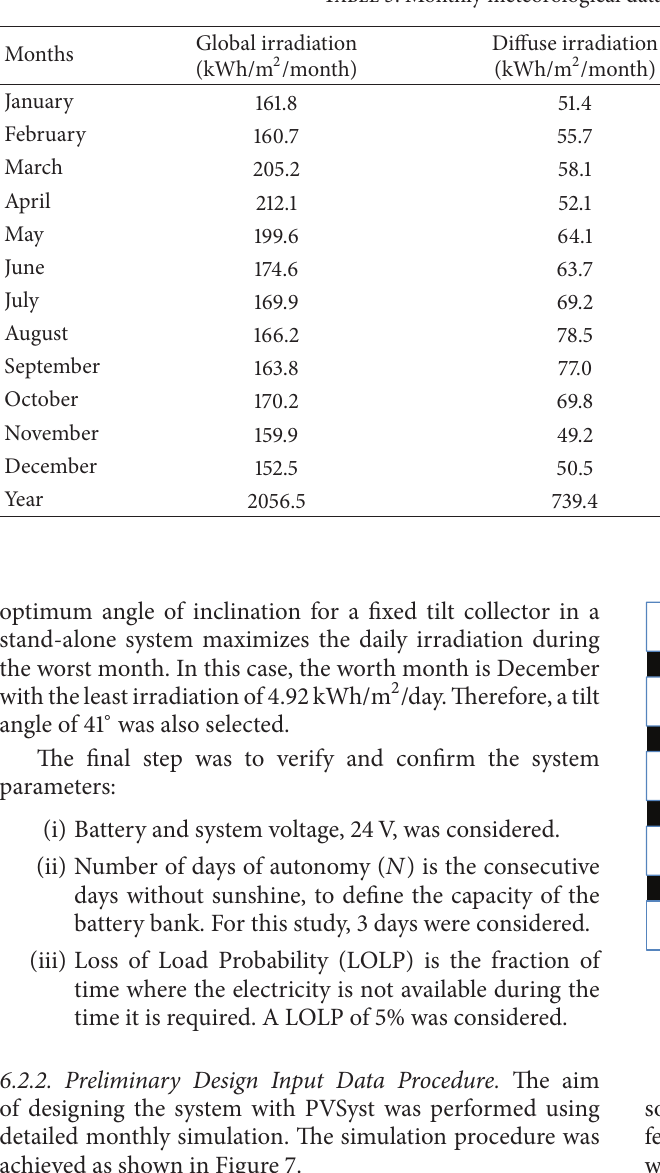
Table 3: Monthly meteorological data imported to the PVSyst [18].